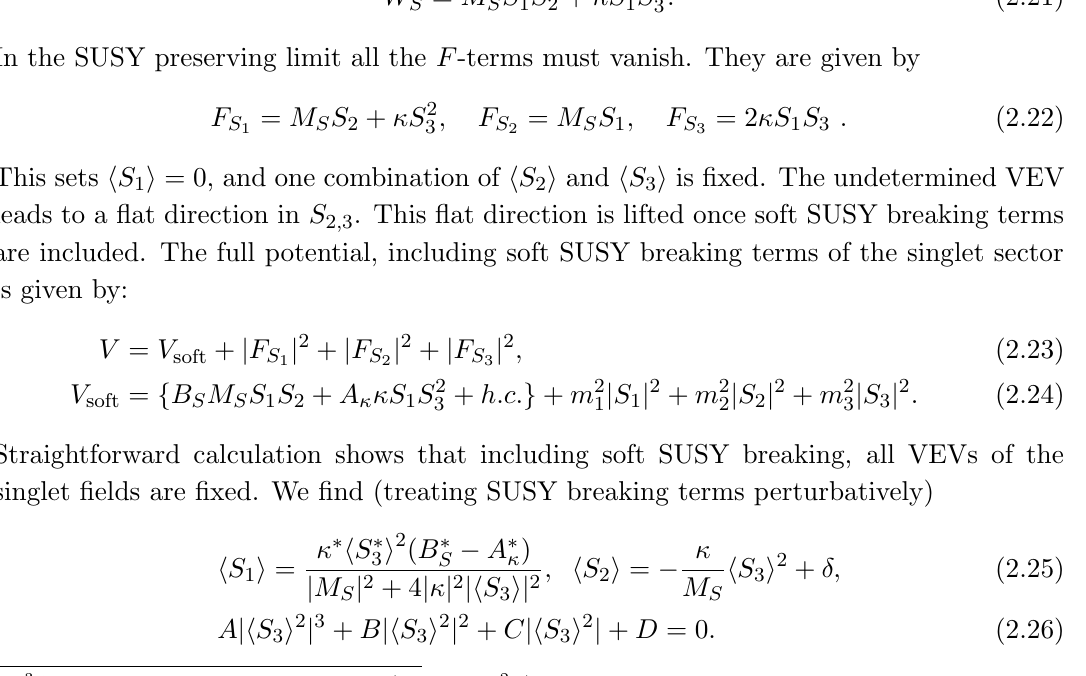
X ) = 4. Note that except (cid:1) 0 (cid:0) ; 126 ; 126 and 210 VEVs leave a global H H H H